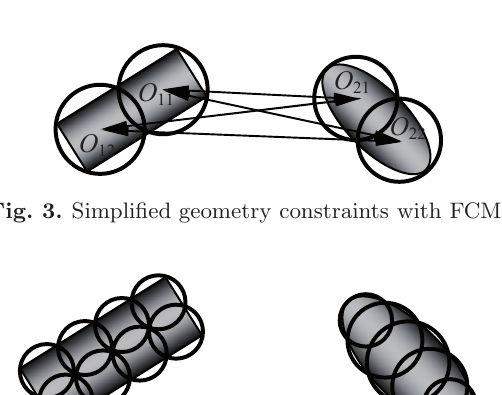
Fig. 2. Two components without any approximation.